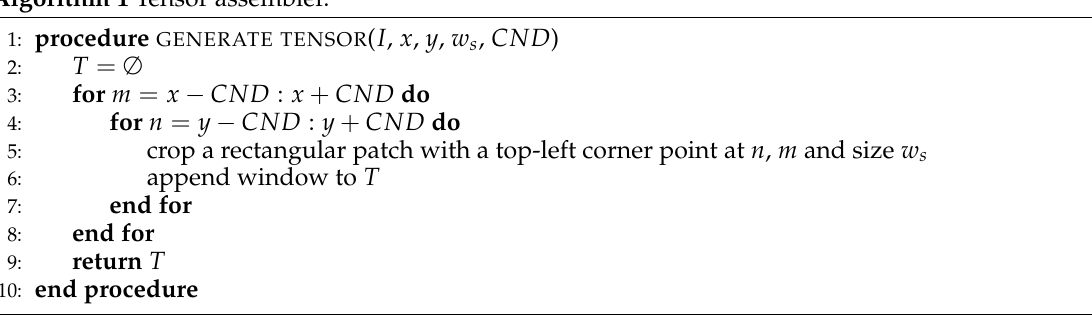
Algorithm 2 Filtering